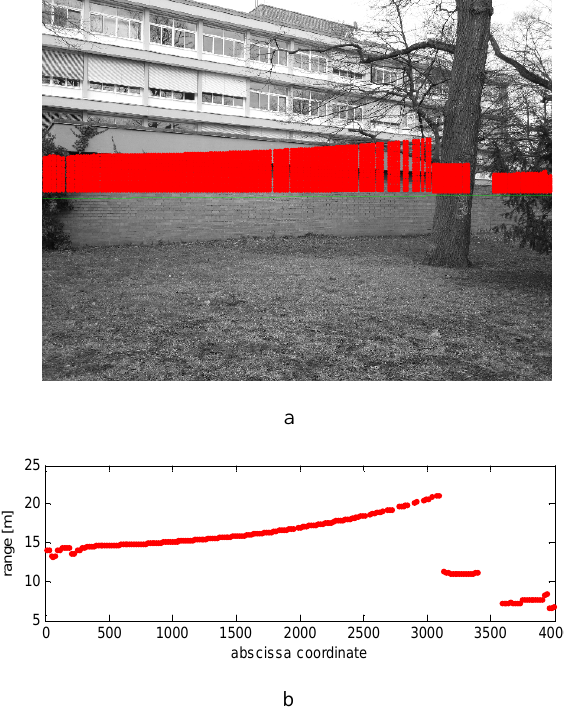
Figure 3. Calibration results: (a) outdoor scene with scan line (green solid line) and qualitative representation of the range values (red dotted vertical lines), (b) corresponding range values.